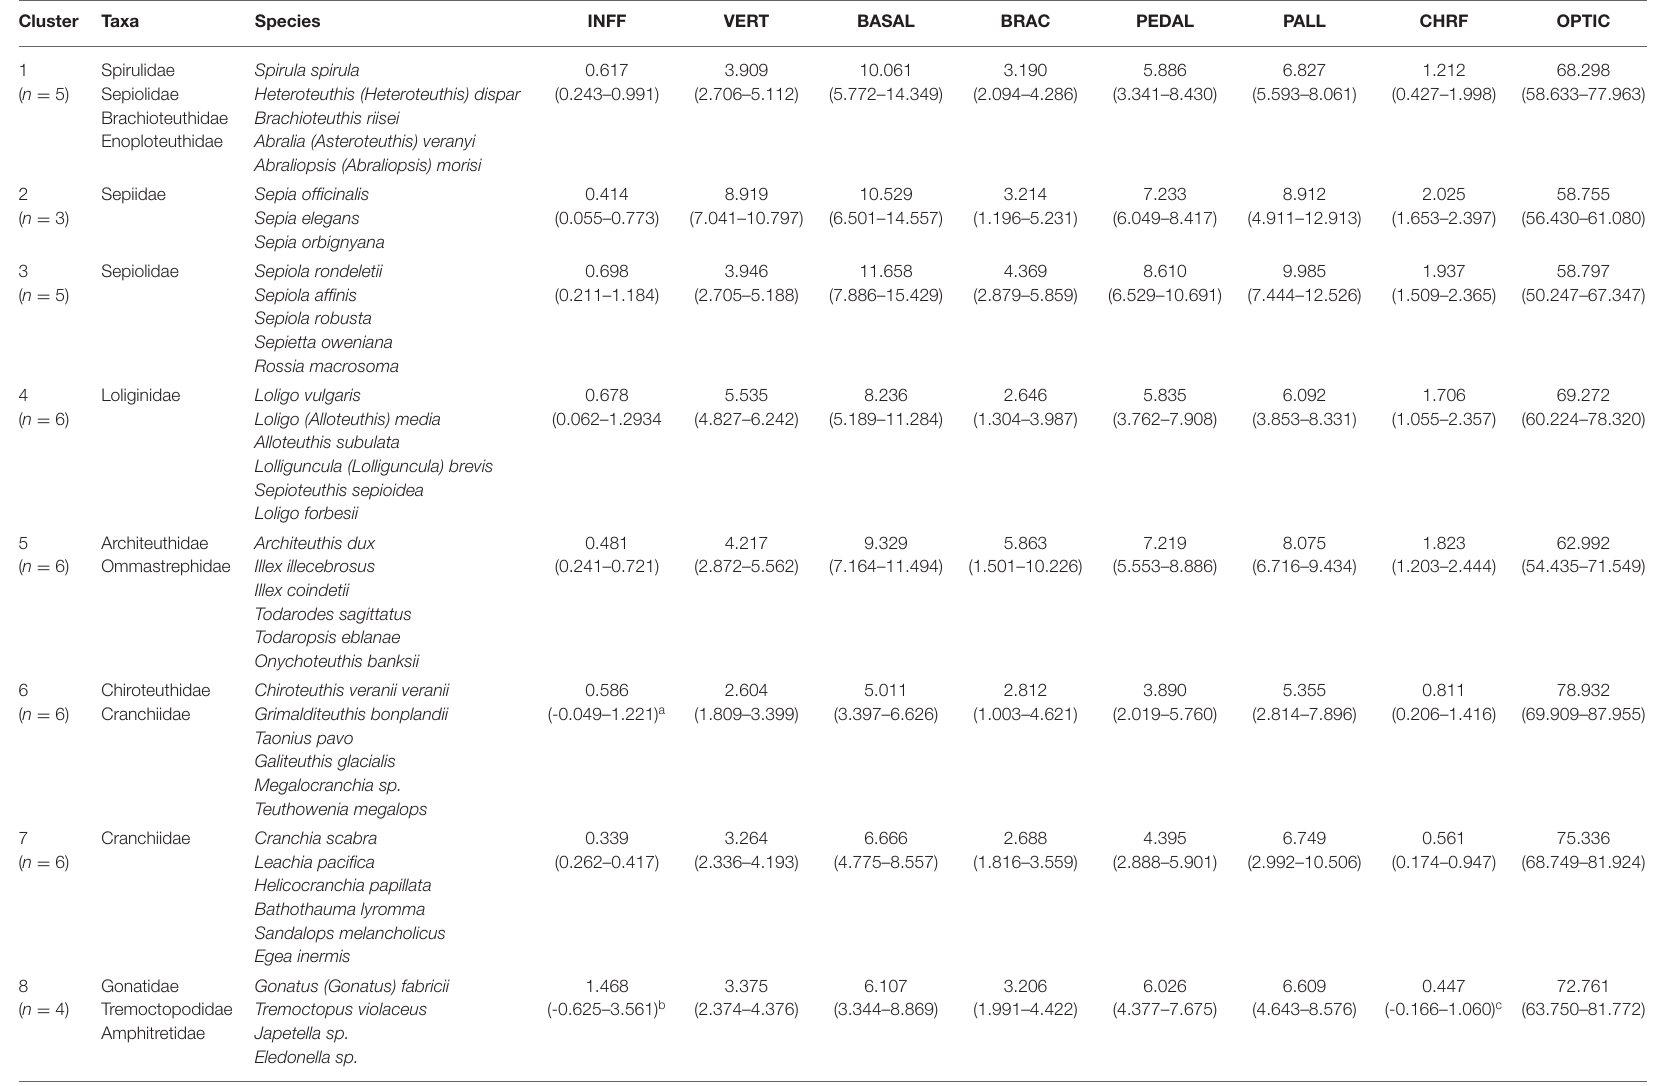
TABLE 3 | The mean proportions of the eight brain regions (brain-functional sets) for each of the ten clusters identified after the hierarchical cluster analysis (see Figure 3 ). Cluster Taxa Species INFF VERT BASAL BRAC PEDAL PALL CHRF